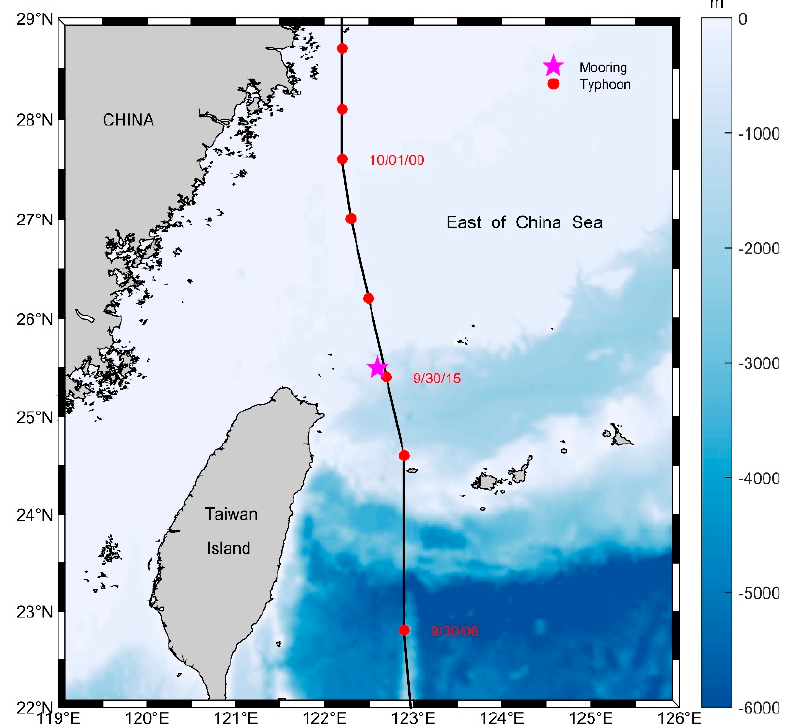
Figure 1. Bathymetry of the southern East China Sea based on ETOPO1 data. The purple star indicates mooring position. The black solid line represents the track of typhoon Mitag in 2019. Typhoon Mitag’s center denoted by dots; red dots indicate intensity of typhoon Mitag, as shown in the legend.